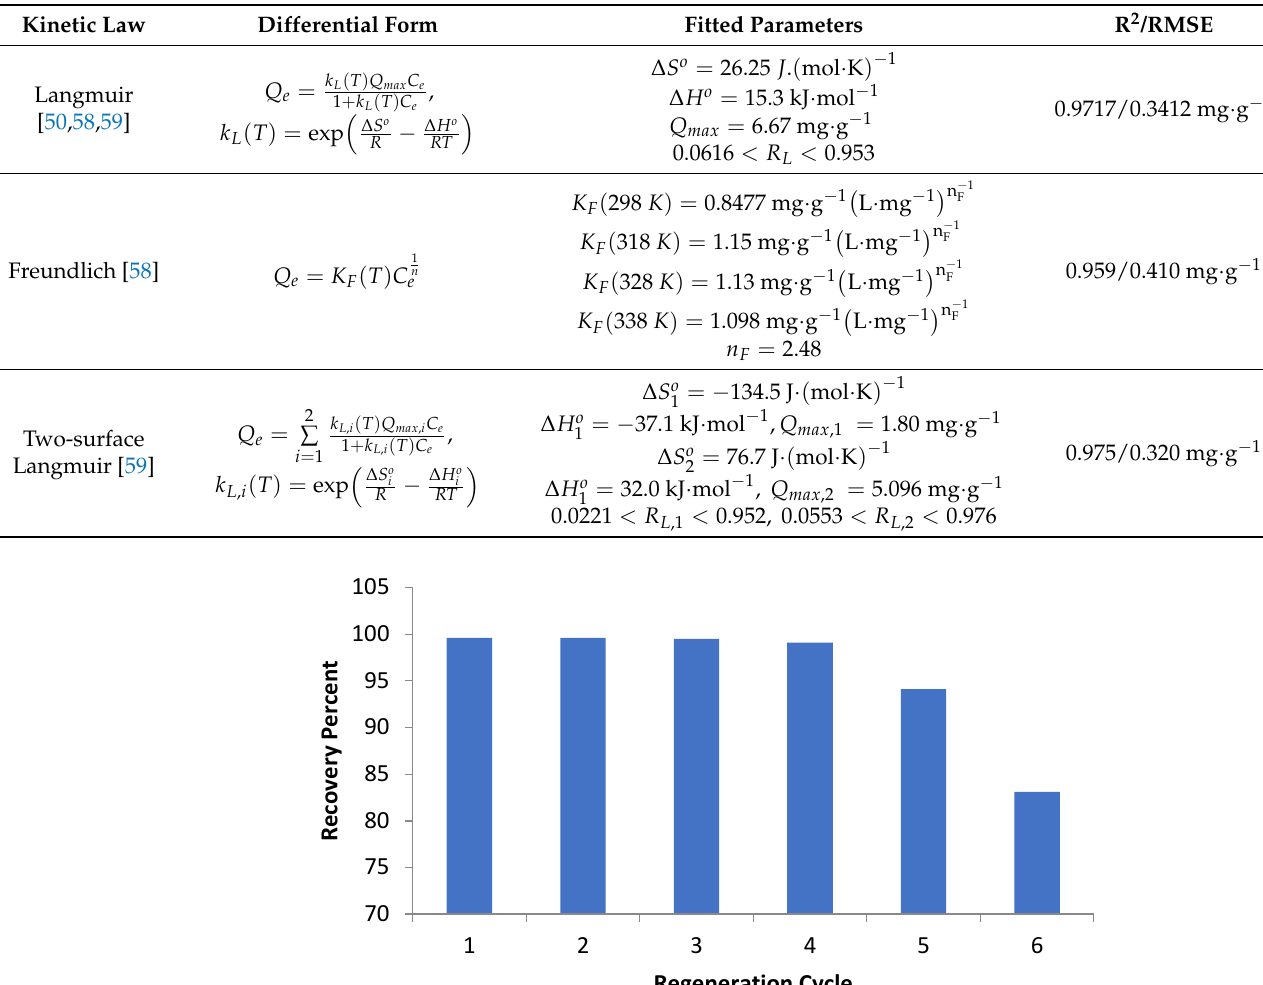
Table 6. Summary of tested adsorption isotherms, fitted parameters, coefficient of determination (R 2 ), and root-mean-square error (RMSE) as a measure of goodness of fit for various isotherm models.